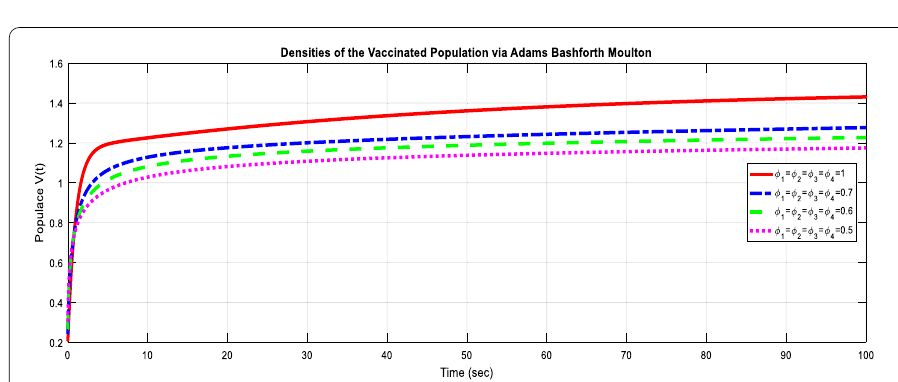
Figure 28 Dynamic of populace V ( t ) by varying the value of φ